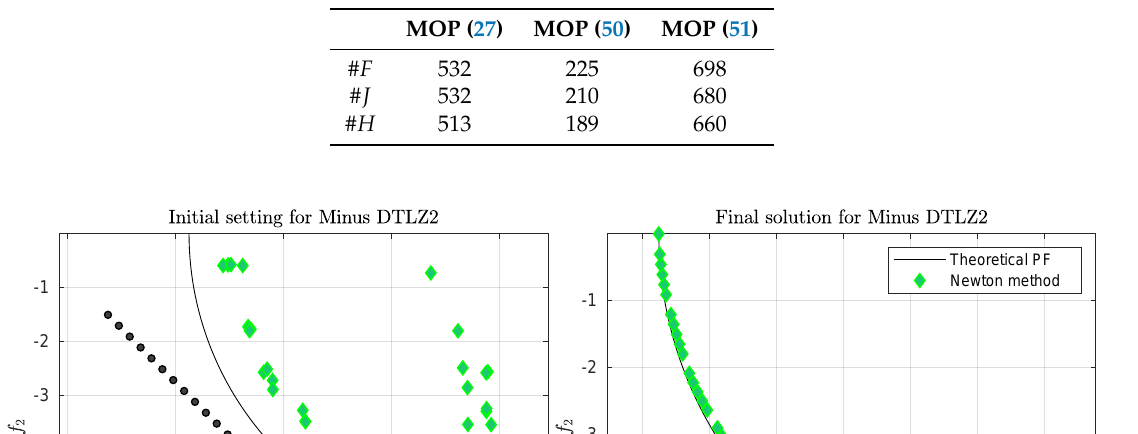
Table 13. Number of function (# F ), Jacobian (# J ), and Hessian (# H ) calls used by the ∆ 2 method using bootstrapping for the three test problems.